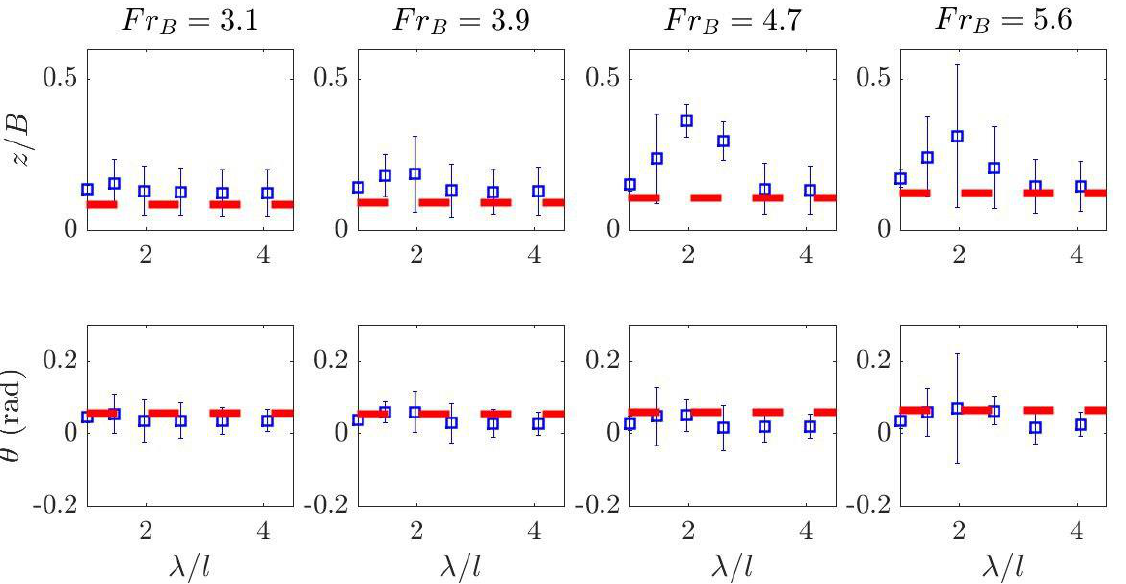
Figure 8. Mean values of the heave and pitch motions of Model B operating in a head sea. The dashed red line shows the calm-water performance of the model in calm-water conditions. The error bars are the amplitude of the heave and pitch motions.